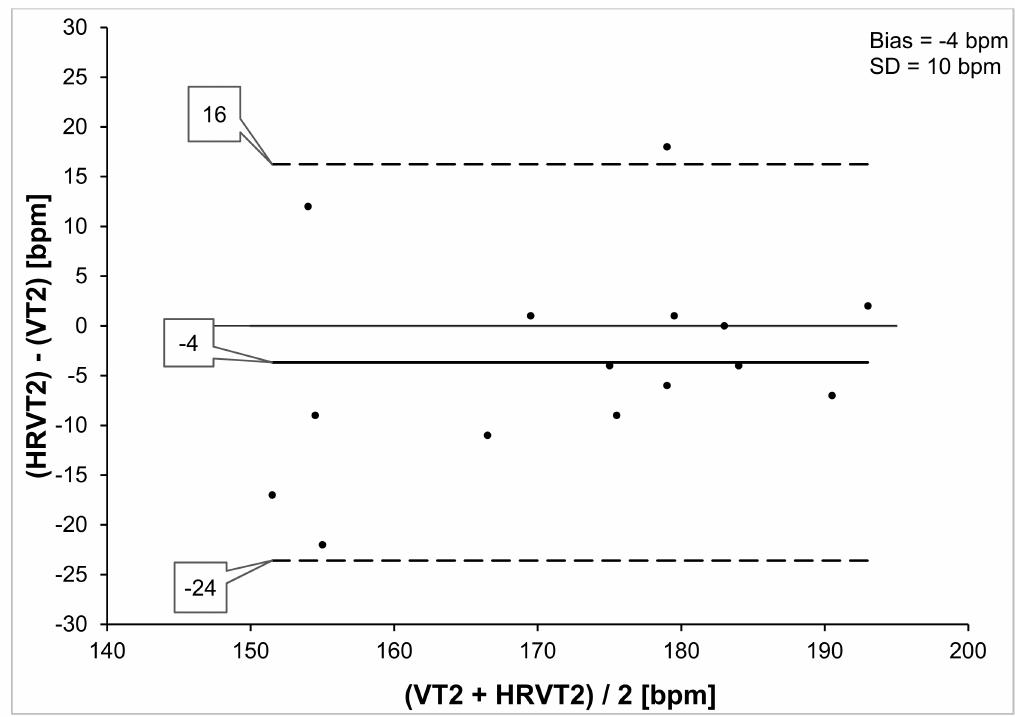
Figure 3. Bland–Altman analysis VT2 HR vs. HRVT2 HR for all participants. Center line represents the mean difference between each paired value, the top and bottom lines are 1.96 standard deviations from the mean